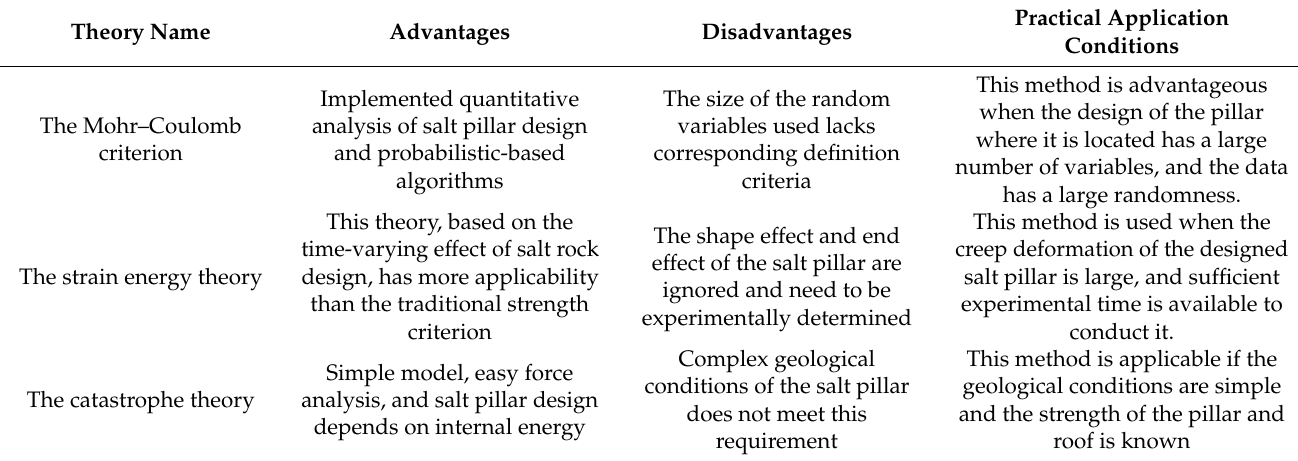
Table 2. Comparison of different mine pillar design